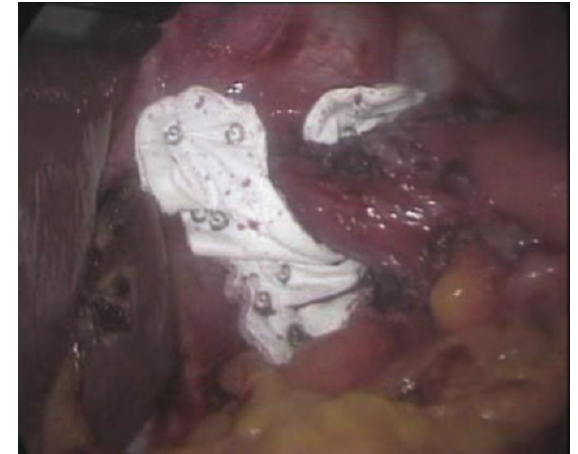
Figure 6. Dual V shaped graft.